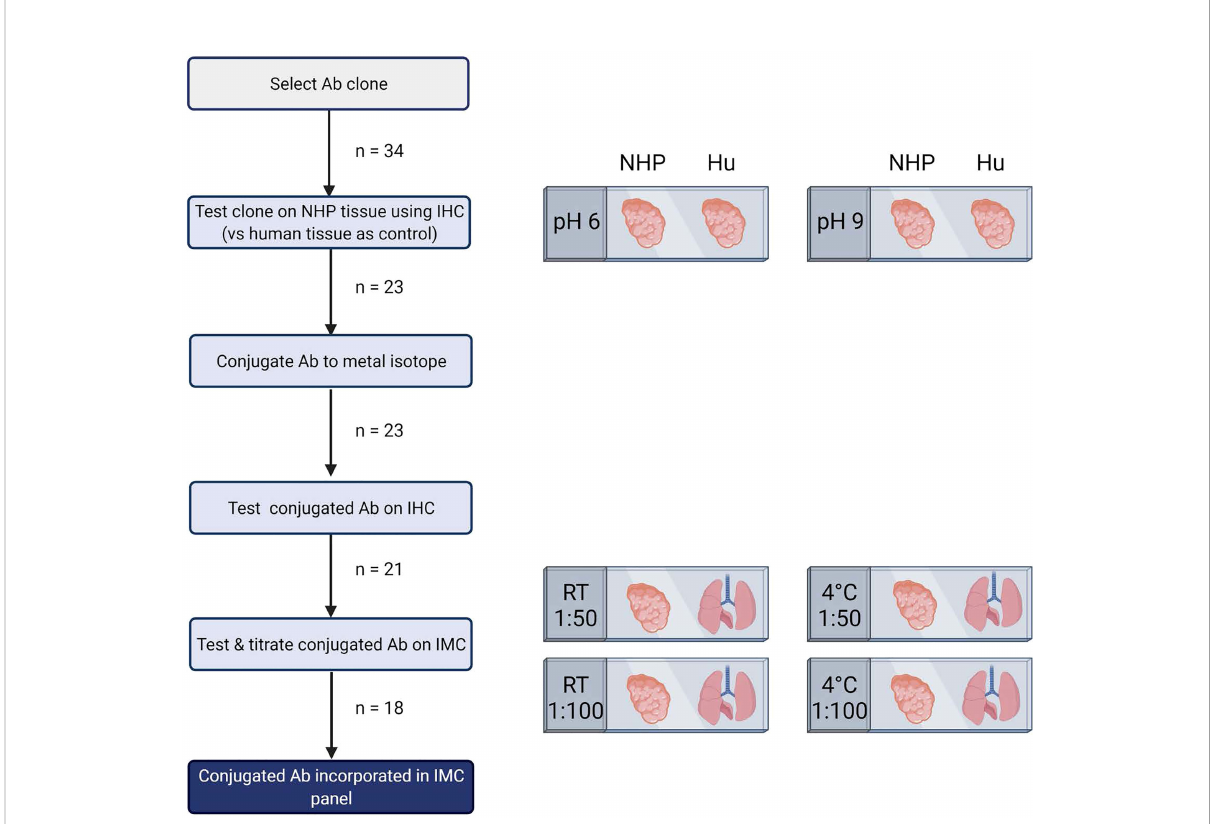
FIGURE 1 Schematic representation of pipeline for development of imaging mass cytometry panel for NHP tissue. Antibody testing steps and the number of antibodies included in each step are shown. This fi gure was created with